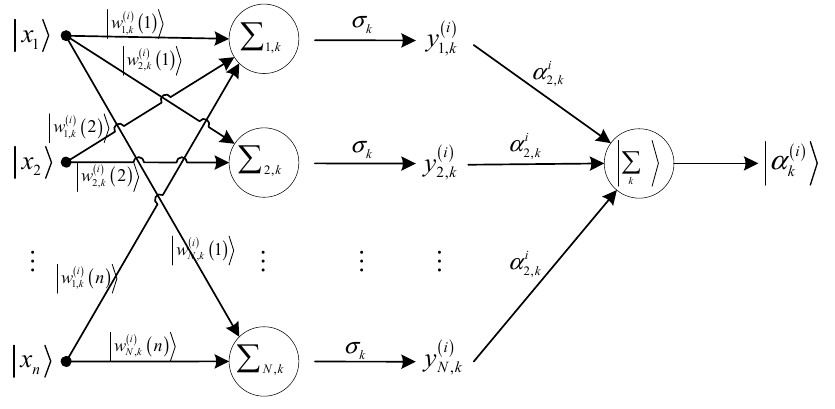
(cid:12) (cid:69) ( i ) (cid:12) of a QANN , where i = 1,2; k = 1,2, . . . , M . (cid:12) α k